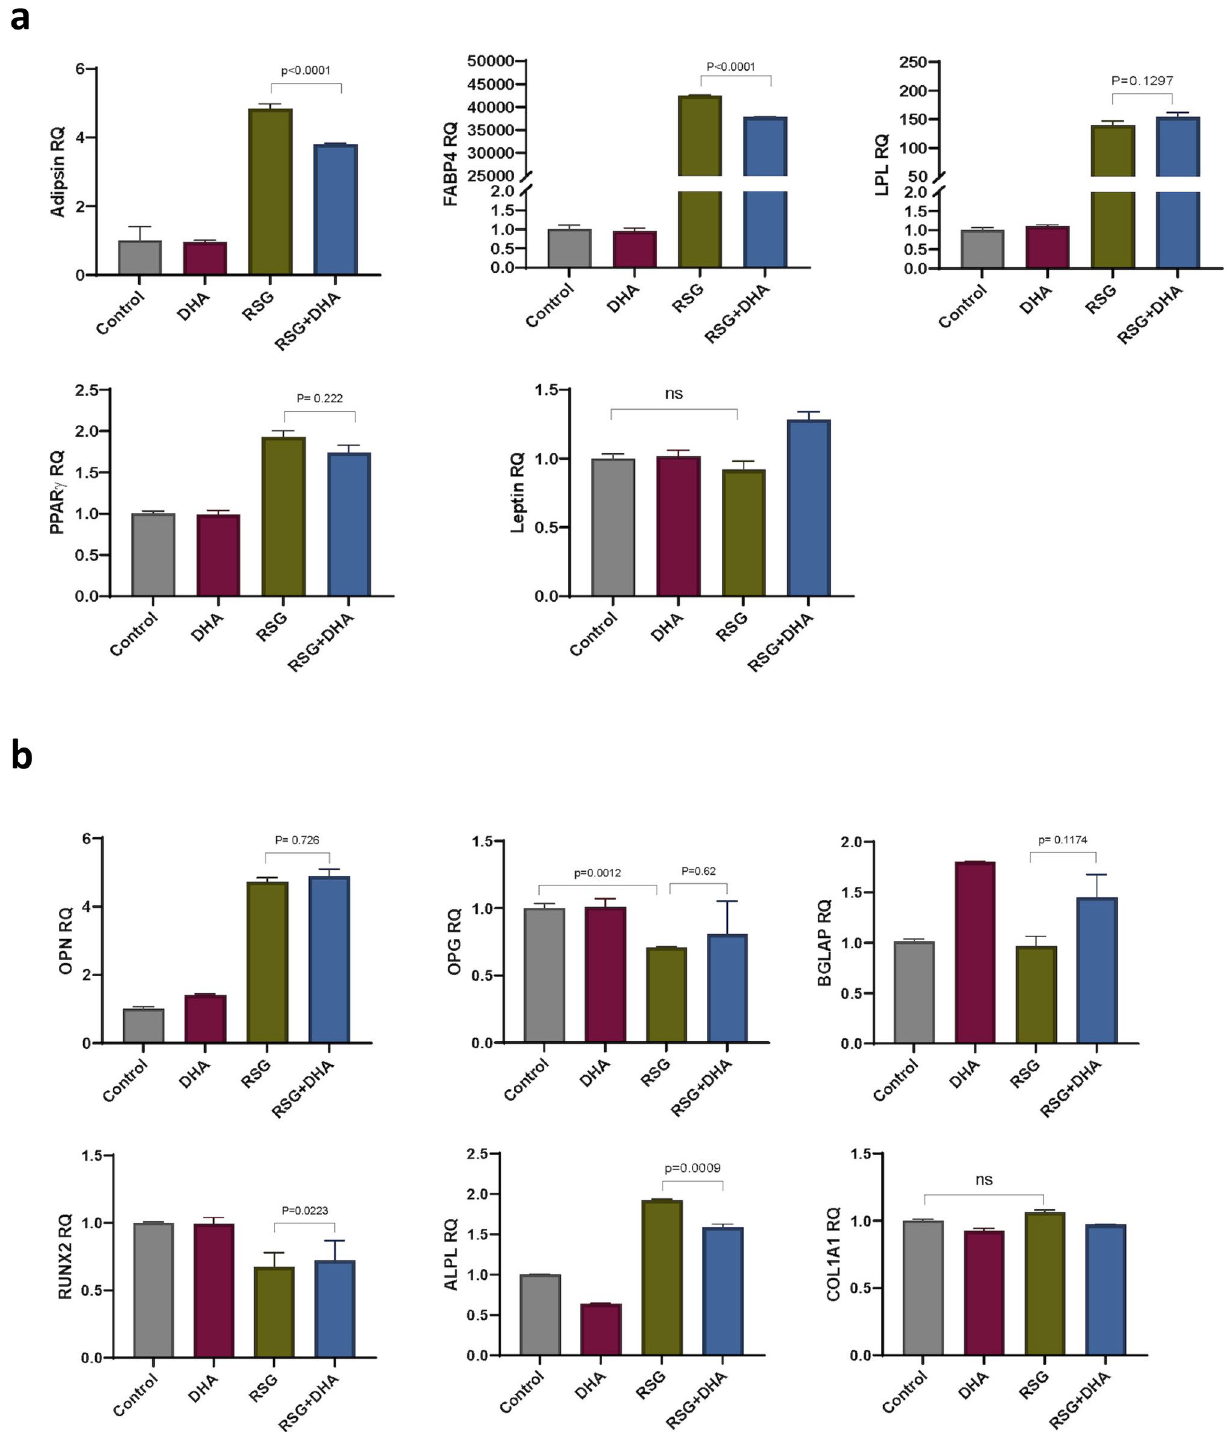
Figure 6. Effect of RSG with or without FO on gene-expression of osteo-differentiated Mesenchymal Stromal Cells (MSCs). Gene expression of adipogenic ( a ) and osteogenic ( b ) markers in MSC differentiated in osteogenic medium with the presence or absence of RSG, DHA, and combination of RSG and DHA. Relative quantification of gene expression for Adipsin, FABP4, LPL, PPARγ, Leptin, OPN, OPG, BGLAP, RUNX2, ALPL, and COL1A1. Each bar represents the RQ mean ± 95% CI from two donors in triplicates. Value with different superscripts is significantly different at p < 0.05 by one-way ANOVA test followed by Dunnett’s multiple comparisons tests with RSG group. ns p-value non-significant, RSG rosiglitazone, EPA eicosapentaenoic acid, DHA , docosahexaenoic